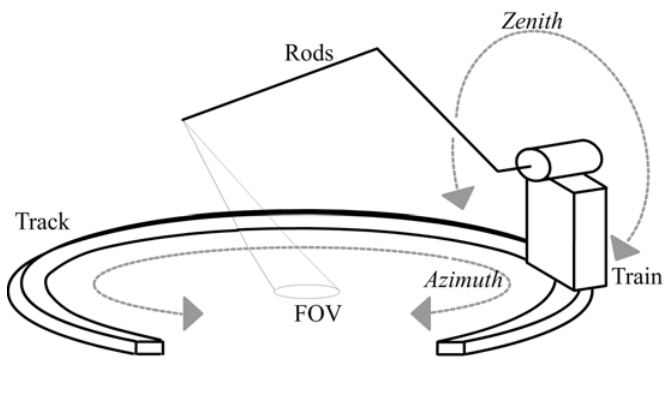
Figure 2. Schematic of the